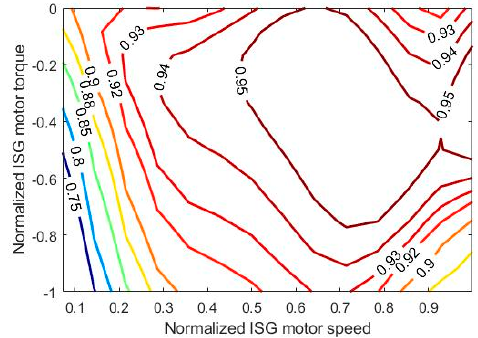
Figure 3. Cloud map of normalized ISG motor efficiency .